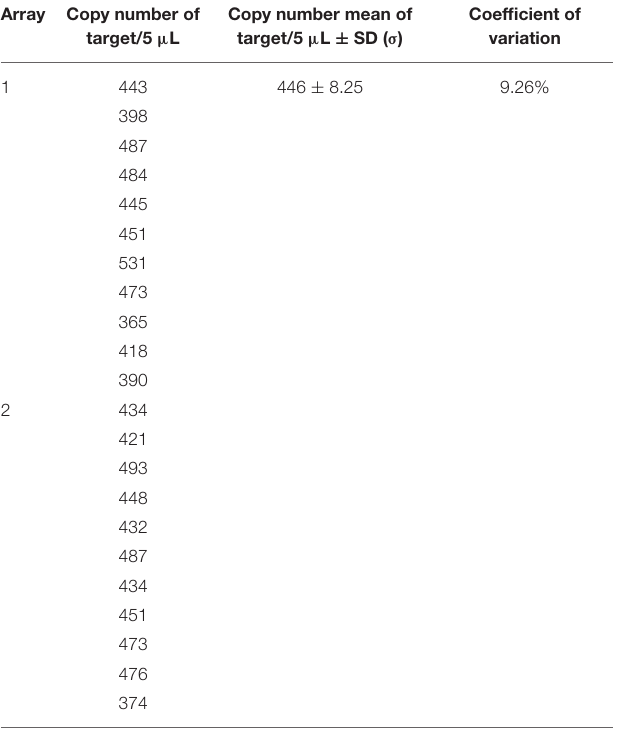
TABLE 5 | Copy numbers obtained on dilution slightly adapted of genomic DNA at ∼ 500 copies/5 µ L by digital PCR on a Biomark TM HD system. Array Copy number of target/5 µ L